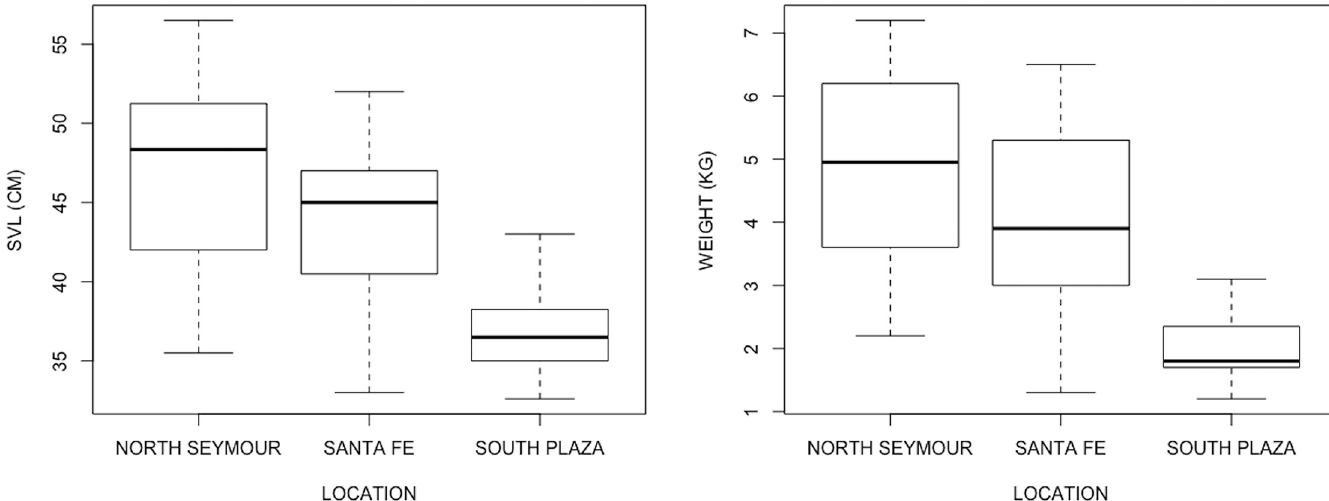
Fig 1. The interspecific population comparison among land iguanas from the three studied islands showed large and highly significant differences in body size (SVL: Kruskal Wallis Test: X 2 = 17.484, df = 2, p < 0.001) and weight (Kruskal Wallis Test: X 2 = 21.919, df = 2, p-value < 0.001).